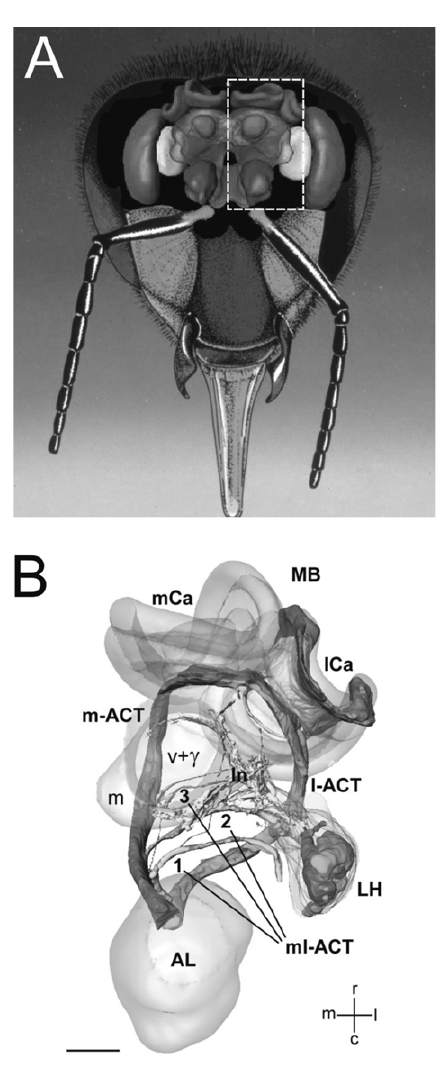
Figure 2. The basic organization of the honeybee olfactory system. (A) Frontal view of the brain with the main olfactory centers. (B) Three- dimensional reconstruction of the olfactory circuit based on confocal microscopy (corresponding to the bees’ left half-brain, see broken line in (A) ; AL: antennal lobe; LH: lateral horn; MB: mushroom body; m-ACT: medial antenno-cerebral tract; l-ACT: lateral antenno-cerebral tract; mCa: medial calyx; lCa: lateral calyx. The three ml-ACTs (mediolateral antenno-cerebral tracts) 1–3 branch off the m-ACT sequentially and innervate the lateral pro- tocerebral lobe to form the lateral network (ln) that spans from the vertical lobe ( v + γ ) to the LH. Scale bar: 100 μ m (Figure 3B adapted from Kirschner et al., 2006 by kind courtesy of Wolfgang